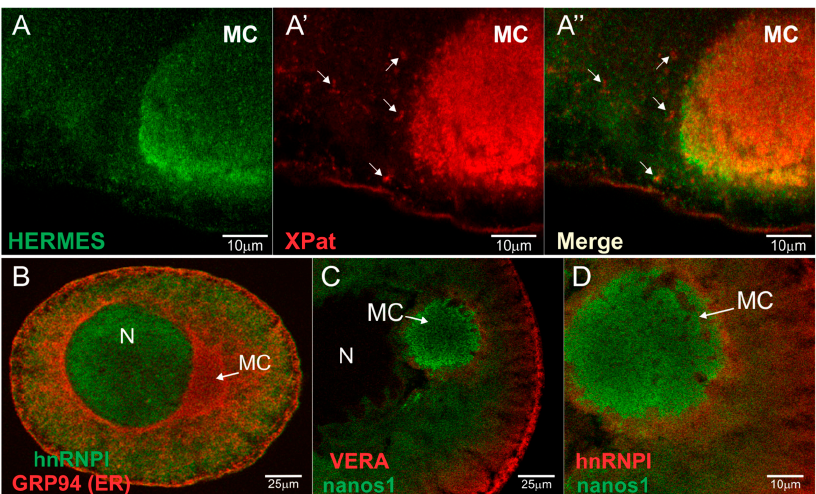
Figure 5. Cellular distribution of Hermes/Rbpms, hnRNP I, Vg1RBP/Vera, and Xpat proteins in the stage I/II oocytes. Confocal images showing immunofluorescence (IF) of stage I/II oocyte with ( A ) anti-Hermes/Rbpms (green) and ( A’ ) anti-Xpat (red) antibodies; ( A’’ ) Superimposed image. White arrows indicate Xpat and Hermes/Rbpms particles are not identical; ( B ) Superimposed images of hnRNP I ( green ) and GRP94 ( red ) proteins. Co-staining with anti-GRP94 reveals the ER enriched within the MC, cortex, and perinuclear region. Note that hnRNP I is excluded from the MC but is present in the nucleus and cytoplasm; ( C ) Merged images of endogenous Vg1RBP/Vera ( red ); or (D) hnRNP I ( red ) with Alexa 488-labeled nanos 3 1 UTR injected 20 h before fixation ( green ). Note that while nanos RNA localizes to the MC, both Vg1RB/Vera and hnRNP I are excluded from it. N: nucleus; MC: mitochondrial cloud. Scale bars are as